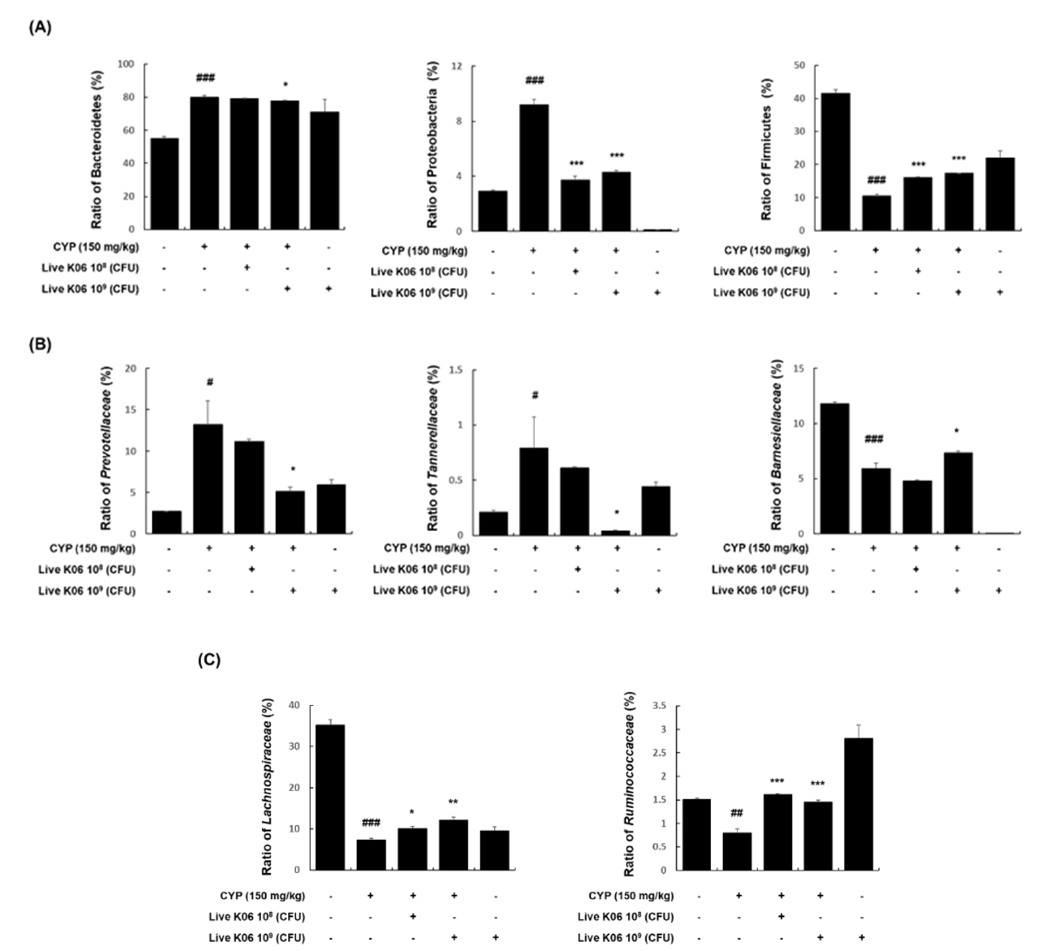
Figure 5. Effects of K040706 treatment on microbiota composition in CYP-treated mice. Genomic DNA was extracted from fecal samples taken from CYP-treated mice or live K040706-treated mice (10 8 or 10 9 CFU / day) and analyzed for bacterial composition using 16S rRNA gene sequences. ( A ) The relative abundance of bacterial phyla in fecal samples from CYP-induced mice. ( B ) Relative distribution of families of Bacteroidetes. ( C ) Relative distribution of families of Firmicutes. Data are presented as mean ± SD of 10 mice. # p < 0.05, ## p < 0.01, and ### p < 0.001 vs. vehicle-treated control mice; * p < 0.05, ** p < 0.01, and *** p < 0.001 vs. CYP-treated